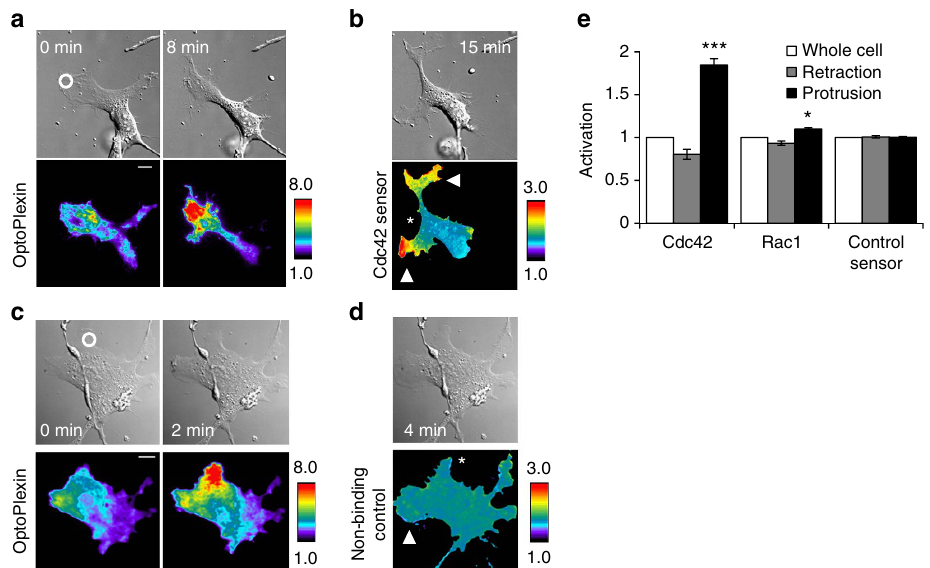
Figure 8 | Local activation of optoPlexin spatially coordinates Cdc42 and Rac1 activities. DIC and TIRF images showing local accumulation and activation of mCherry-OptoPlexin in MC3T3-E1 cells co-expressing a Dora-Cdc42 biosensor ( a ) or its non-binding control ( c ). Upon induction of CIL, a pair of FRET and CFP images were acquired using TIRFM and processed to generate a ratio image for the Dora-Cdc42 sensor ( b ) and its non-binding control ( d ). White circle, region of illumination. Scale bar, 10 m m. Asterisk, induced retraction. Arrowhead, induced protrusion. ( e ) Quantificaiton of the spatial distribution of active Cdc42 and Rac1 in MC3T3-E1 cells after induction of CIL, n ¼ 9–12 cells, means ± s.e.m. are shown. *** P o 0.001 and * P o 0.05, NS not significant, Student’s t